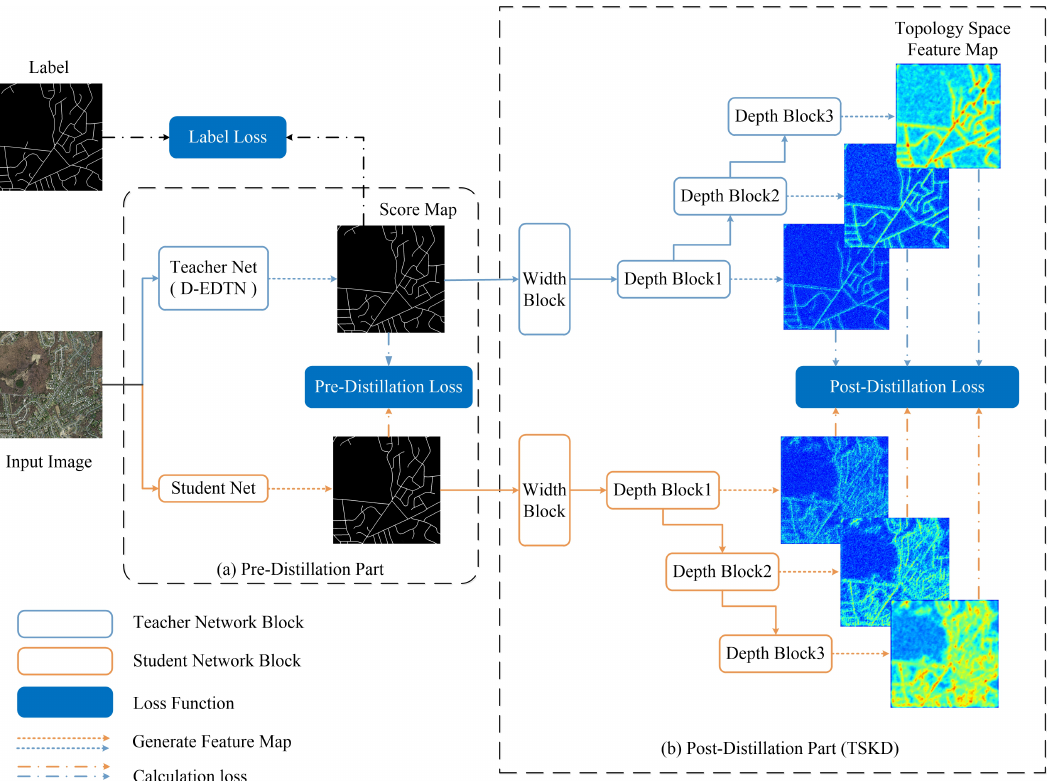
Figure 3. Flowchart of our proposed method for road extraction based on knowledge distillation.